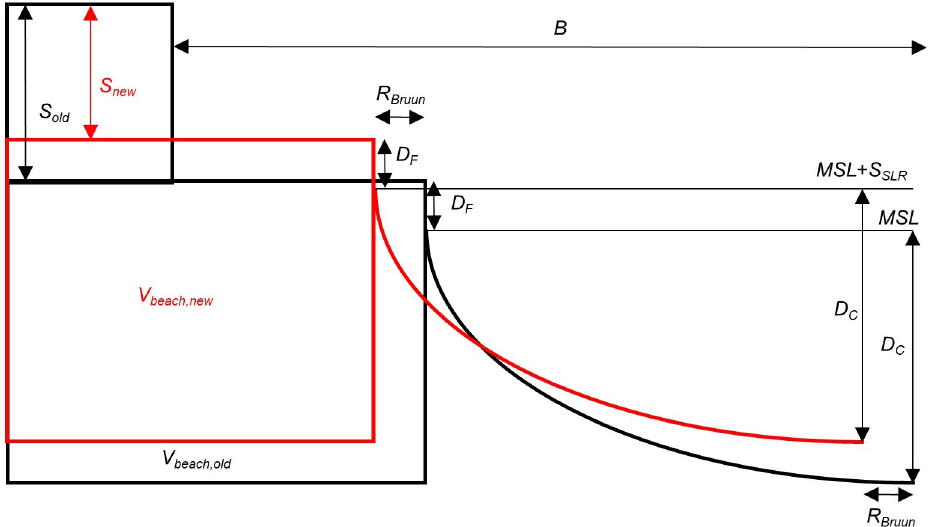
Fig 5. Impact of sea level rise on beach volume and dune height. The beach and dune volumes are for simplicity of the visualisation schematized as rectangular shapes.